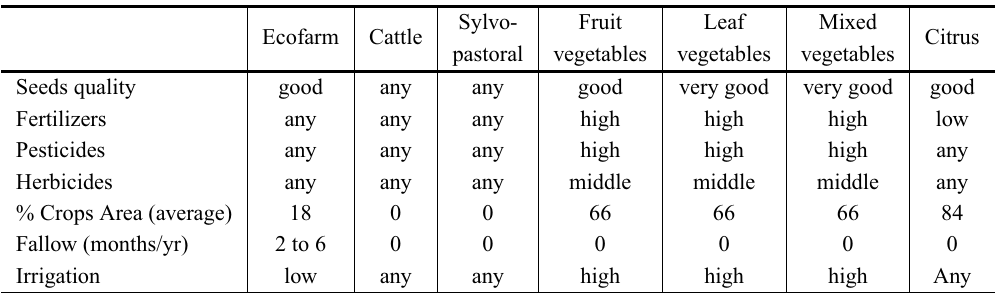
General overview of the agriculture systems in “Córrego Sujo”,